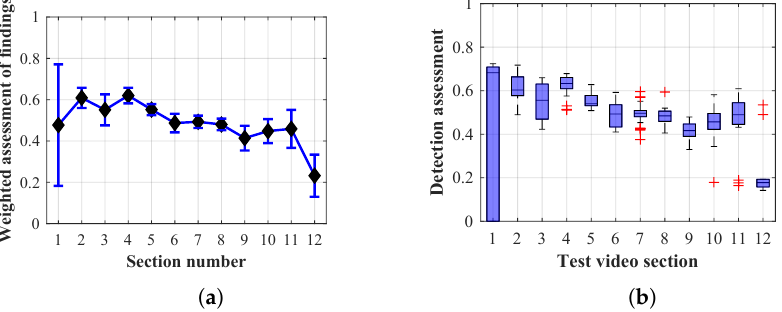
Figure 34. ResultsofMethod1.3withalifespanof12frames. ( a )theweightedaverageratingwiththeaverage mean absolute error of the weighted rating and ( b ) boxplots of the distribution of the statistical sets of the results of the individual sections evaluated indicating: minimum, 1st quartile, median, 3rd quartile, maximum.